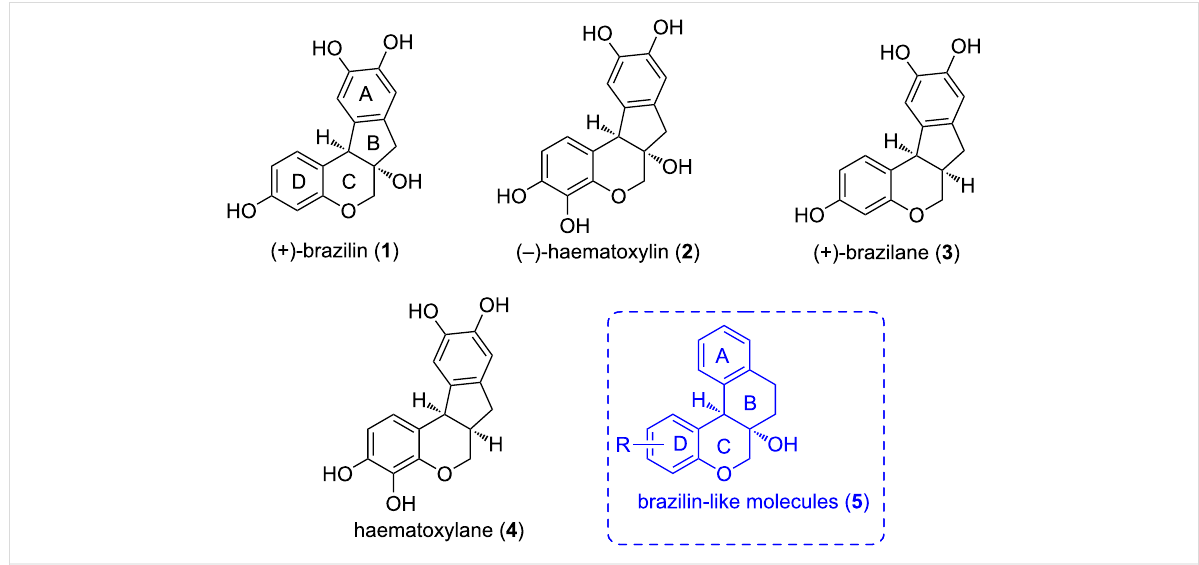
Figure 1: Chroman-based tetracyclic natural products 1 – 4 of the brazilin family and our designed, B-ring-modified analogues of brazilin 5 .